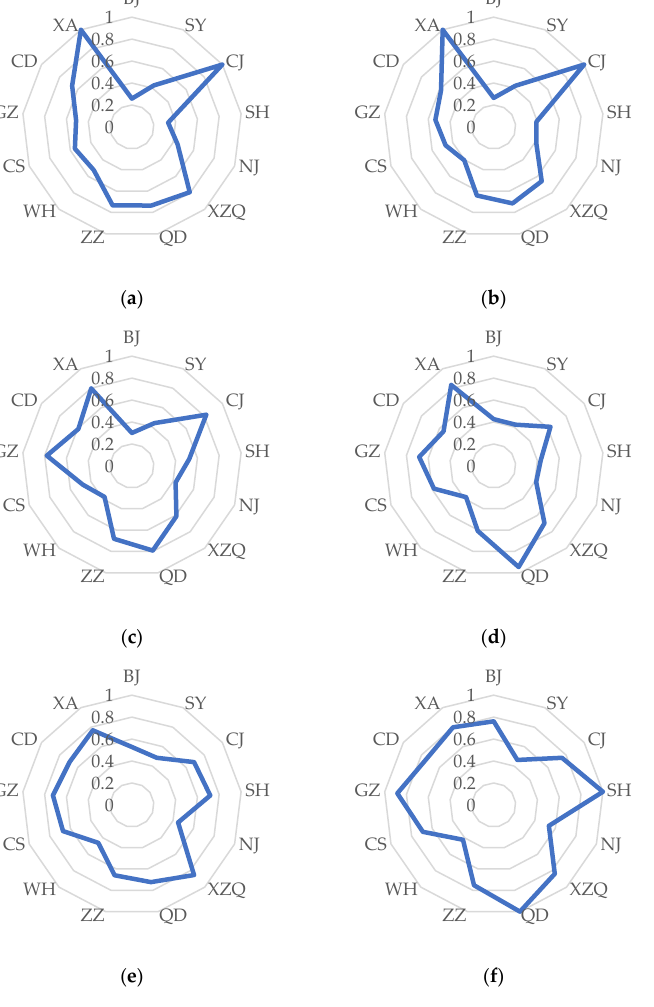
Figure 4. Comparison of the ECILUs in metropolitan areas: ( a ) 2007, ( b ) 2009, ( c ) 2011, ( d ) 2013, ( e ) 2015, and ( f ) 2017.